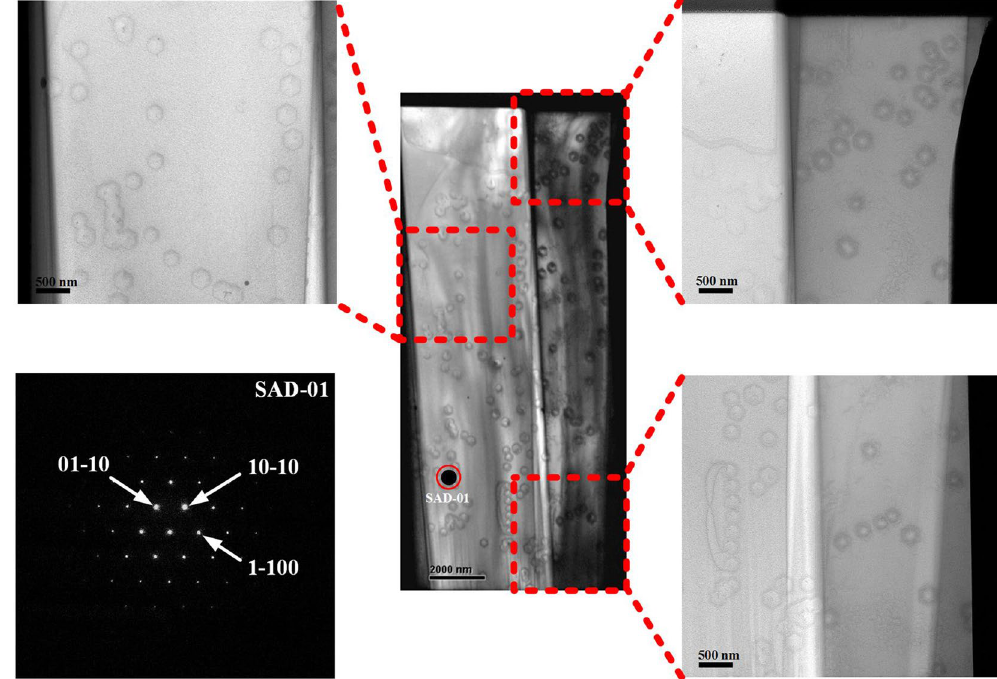
Figure 8. Plan-view TEM images of the green LED specimen including layers of InGaN/GaN MQW, InGaN/ GaN SL, and a fraction of n-GaN with SAD pattern of SAD-01. The TD is clearly observed at the centre of hexagonal